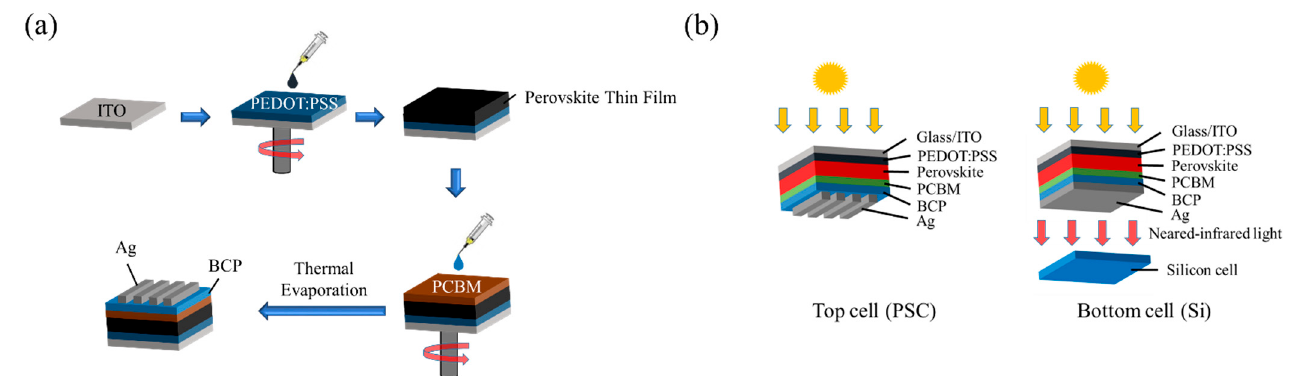
Figure 2. ( a ) Perovskite solar cell device formation. ( b ) Schematic diagram of top cell (PSC) and bottom cell (Si). bottom cell